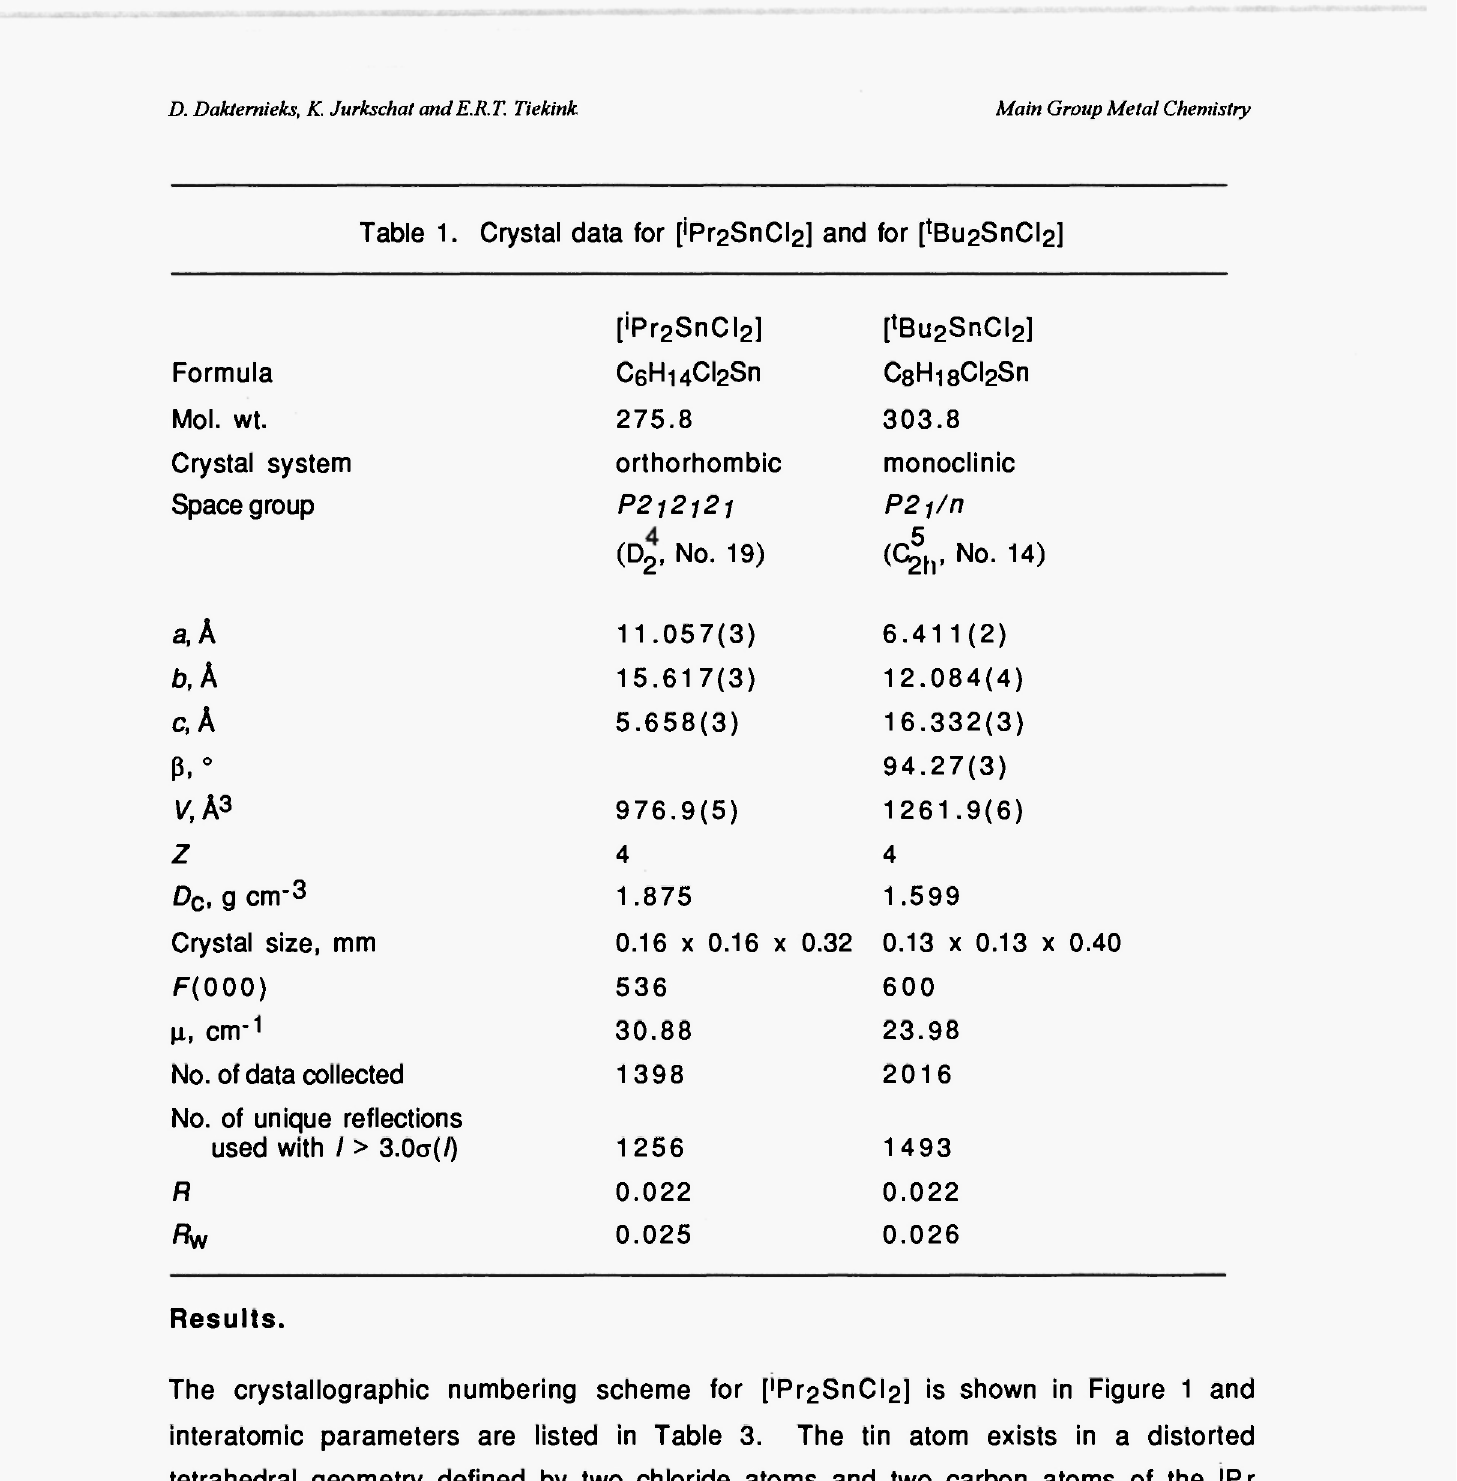
Table 1. Crystal data for [iPr